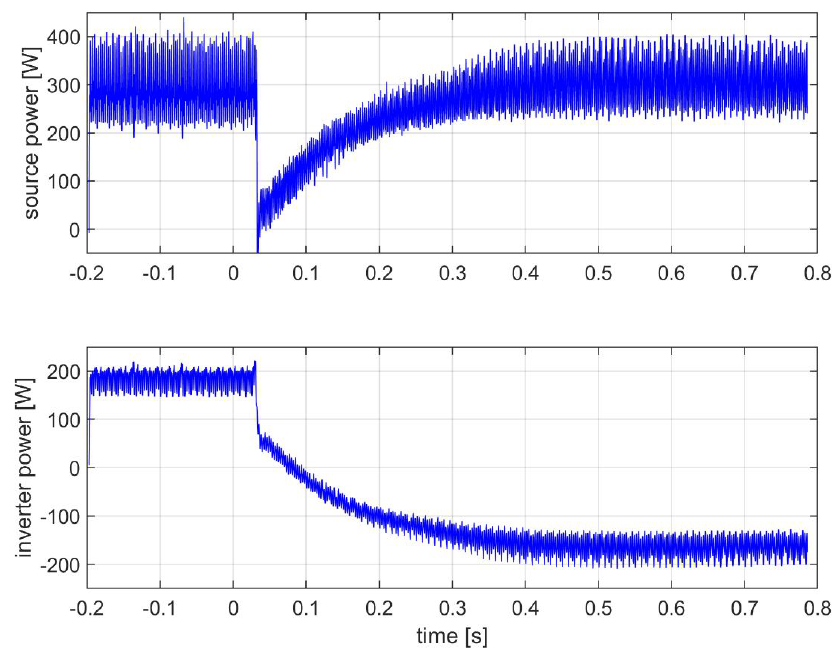
Figure 13. Source and inverter power when the additional load is disconnected.